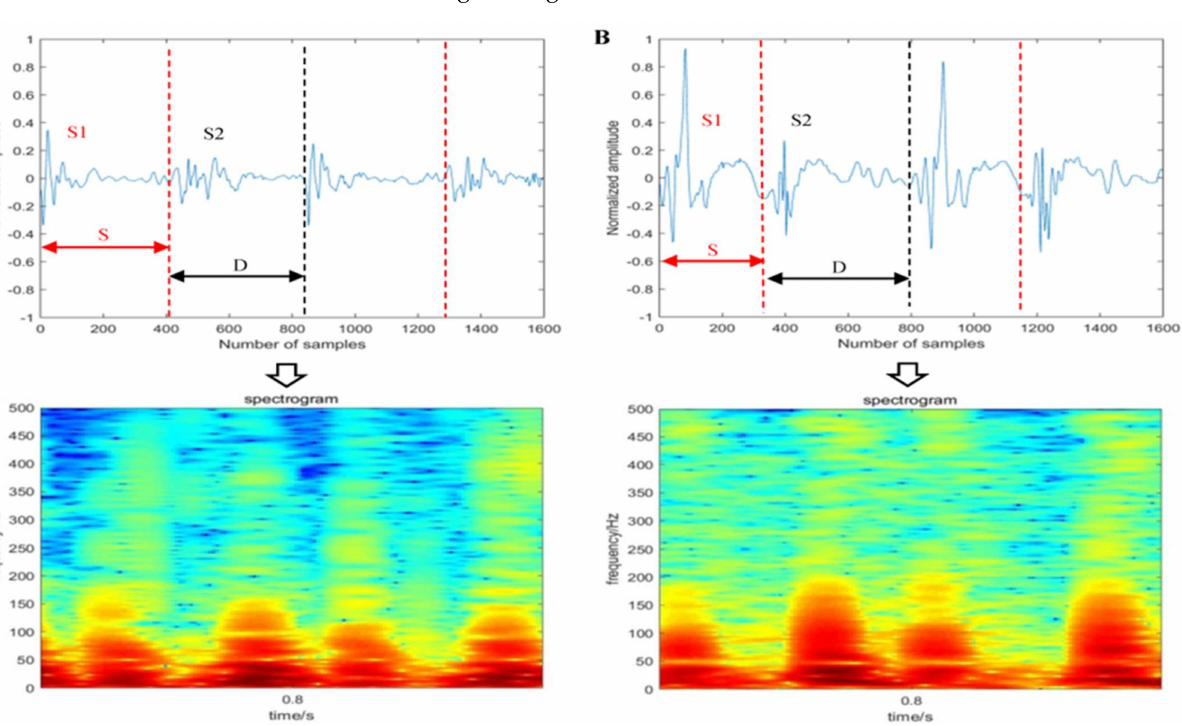
Figure 2. The examples of converting HS samples into spectrogram: ( A ) LVDD group; ( B ) control